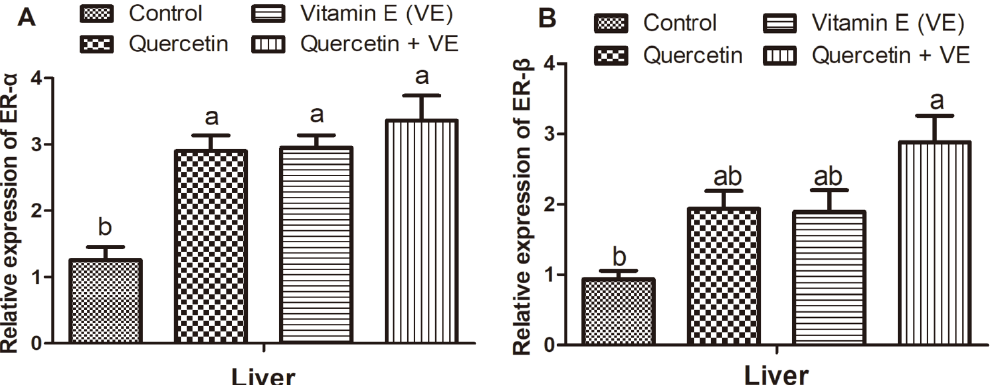
Figure 8. Effects of quercetin, vitamin E, and quercetin + vitamin E on the mRNA expression of liver ER- α and ER- β of the aging breeder hens. Levels of expression of ER- α ( A ) and ER- β ( B ). The values are presented as the mean ± SD. Bars without the same letters differed significantly ( p < 0.05).